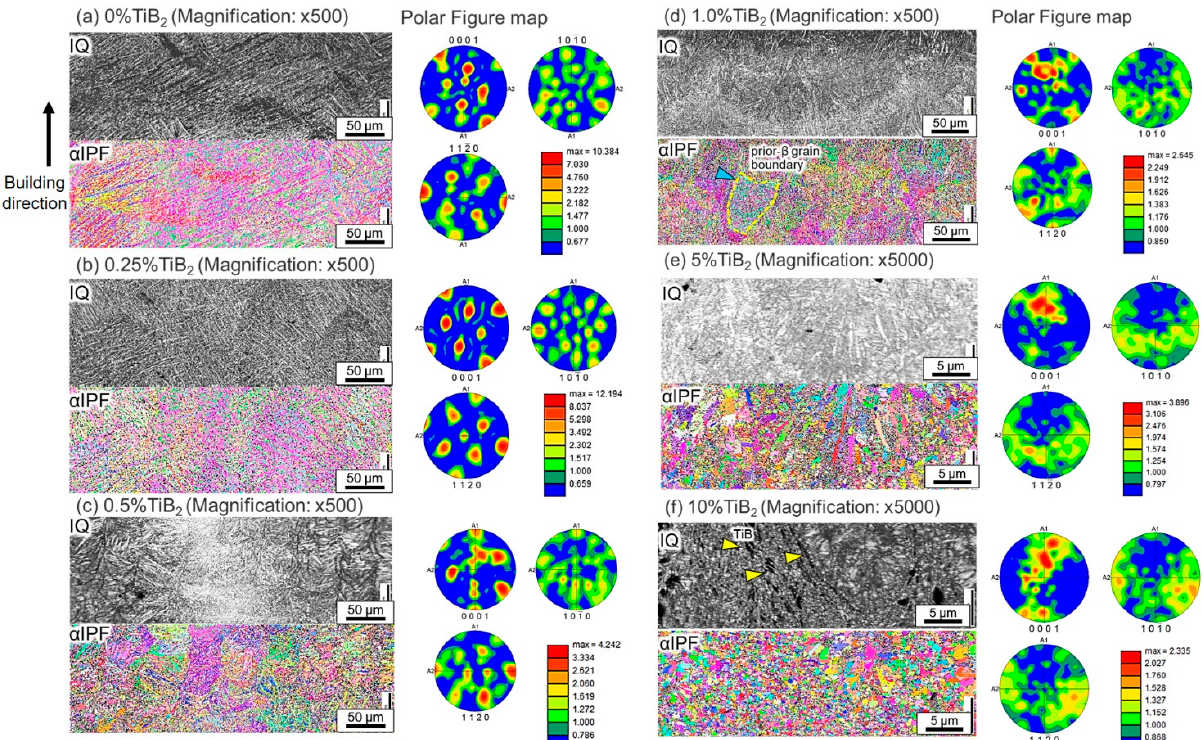
Figure 7. Image quality (IQ), inverse pole figure (IPF), and pole figure maps of α -phase of SLM Ti64- ( a ) 0, ( b ) 0.25, ( c ) 0.5, ( d ) 1.0, ( e ) 5, and ( f ) 10 mass% TiB 2 composites analyzed by SEM-EBSD.